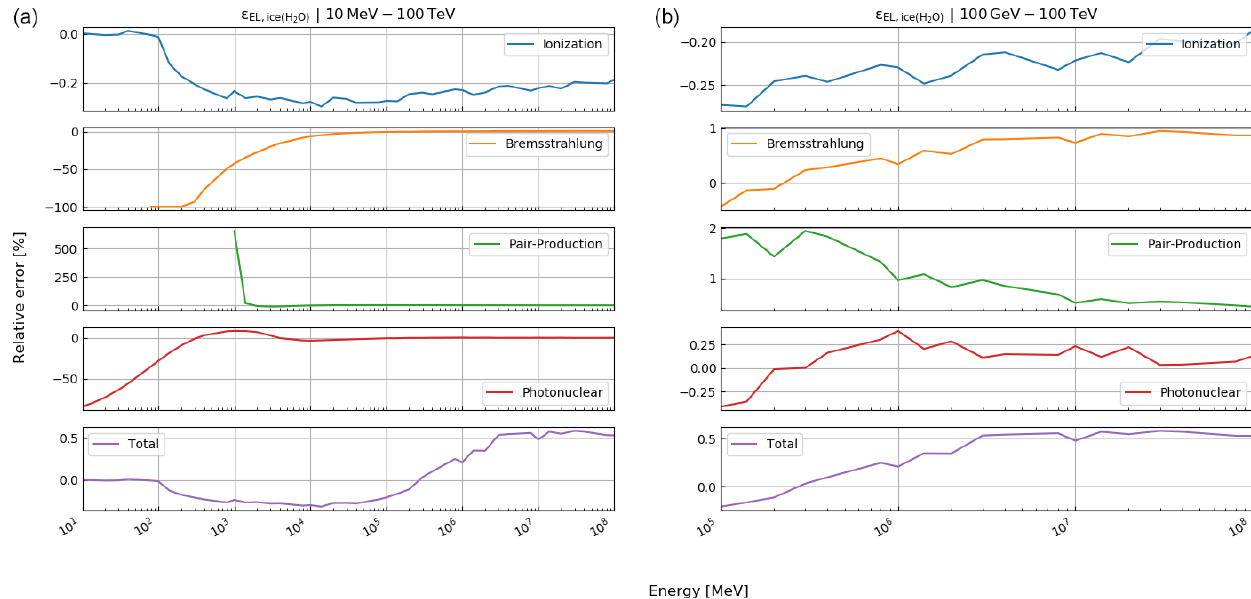
Figure E12. Relative error of our energy loss calculations compared to the tabulated values from Groom et al. (2001) for ice in the energy ranges (a) 10MeV–100TeV and (b)